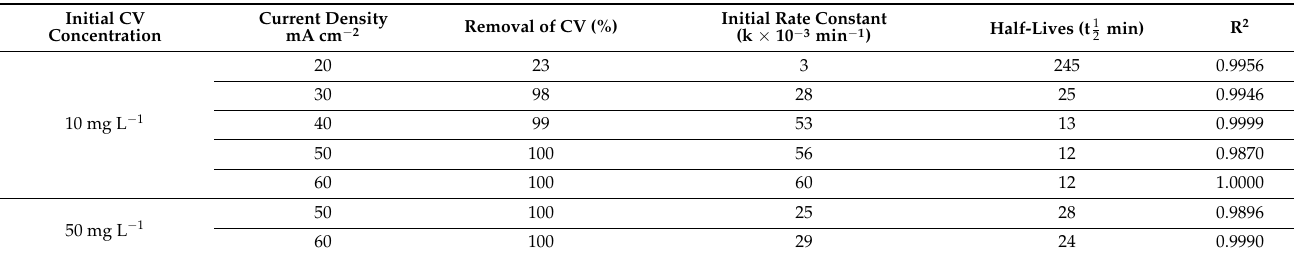
Figure 7. Effect of current density on efficiency of dye CV removal: pH 0 = 7, T = 25 ◦ C ( a ) [CV] 0 = 10 mg L − 1 ; ( b ) [CV] 0 = 50 mg L − 1 ; ( c ) CV removal rate vs. current densities ([CV] 0 = 10 mg L − 1 , initial pH = 7, temperature = 25 ◦ C, Q = 7.2 C/cm 2 ). Table 1. Kinetic parameters of the electrochemical degradation of the CV dye by means of a tin dioxide